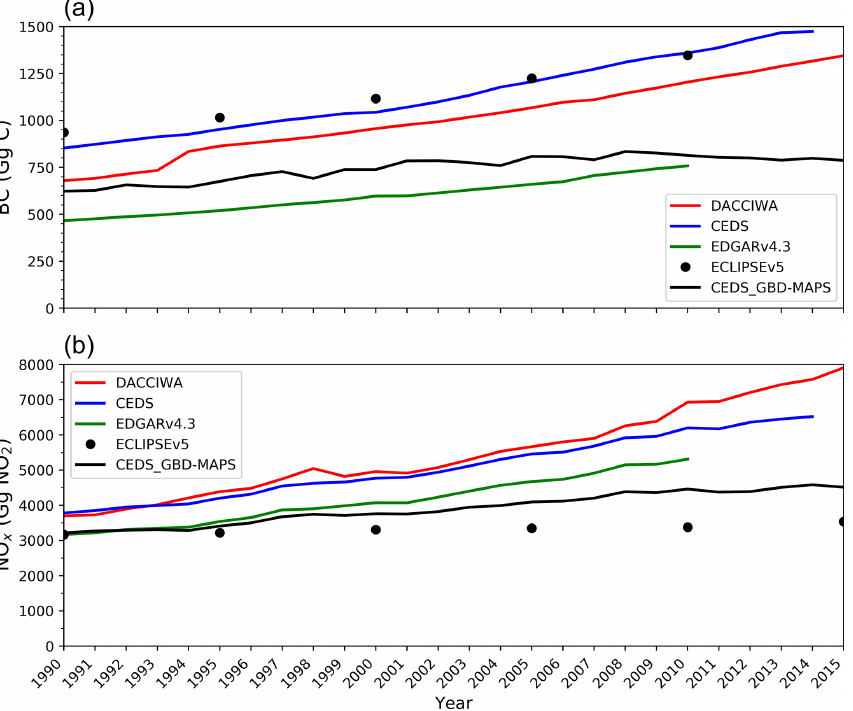
Figure 6. Comparison of BC (a) and NO x (b) between DACCIWA inventory (this work) and global inventories (CEDS, CEDS_GBD-Maps, EDGARv4.3 and ECLIPSEv5